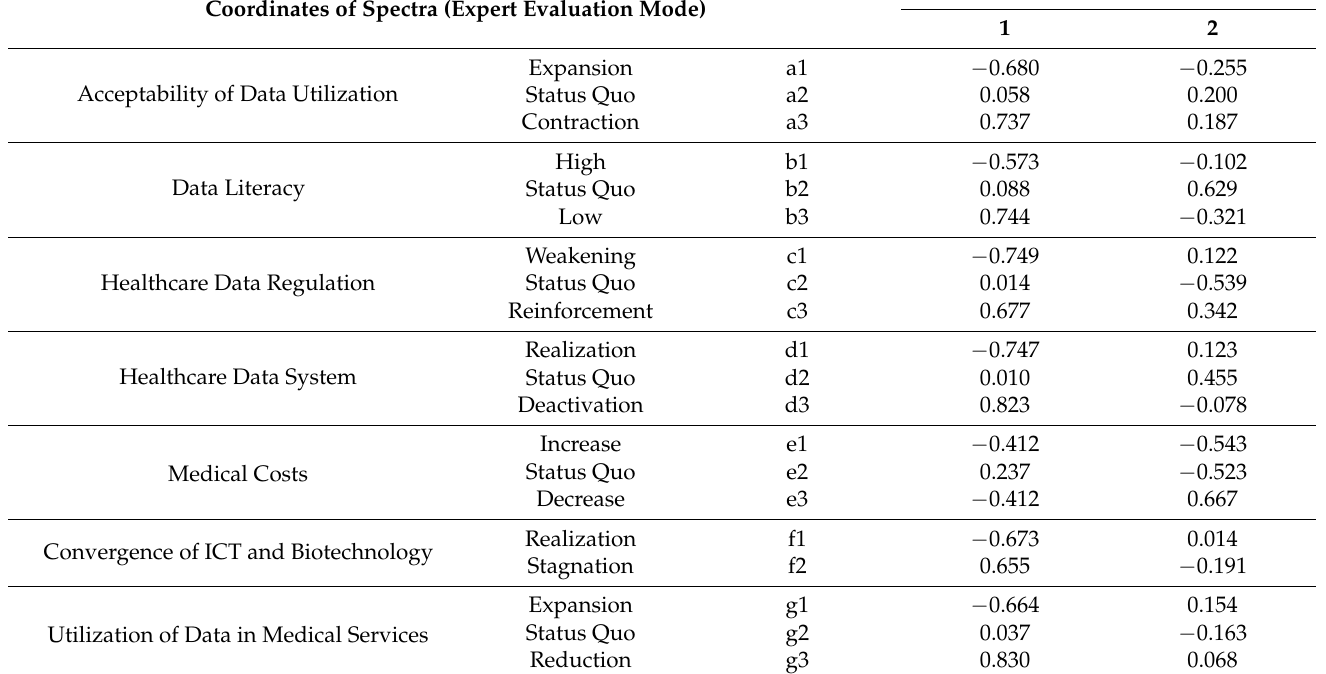
Table 6. Coordinates of spectra (expert evaluation